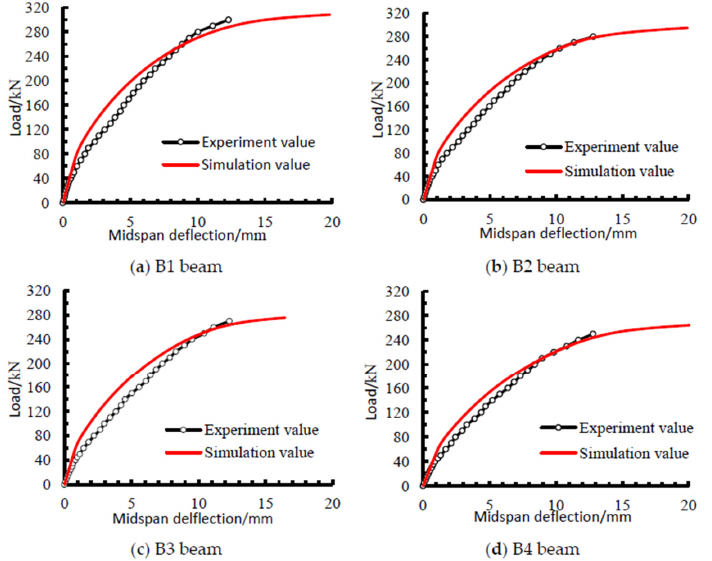
Figure 7. Comparison of midspan load–deflection curves between test results and calculation re- sults.